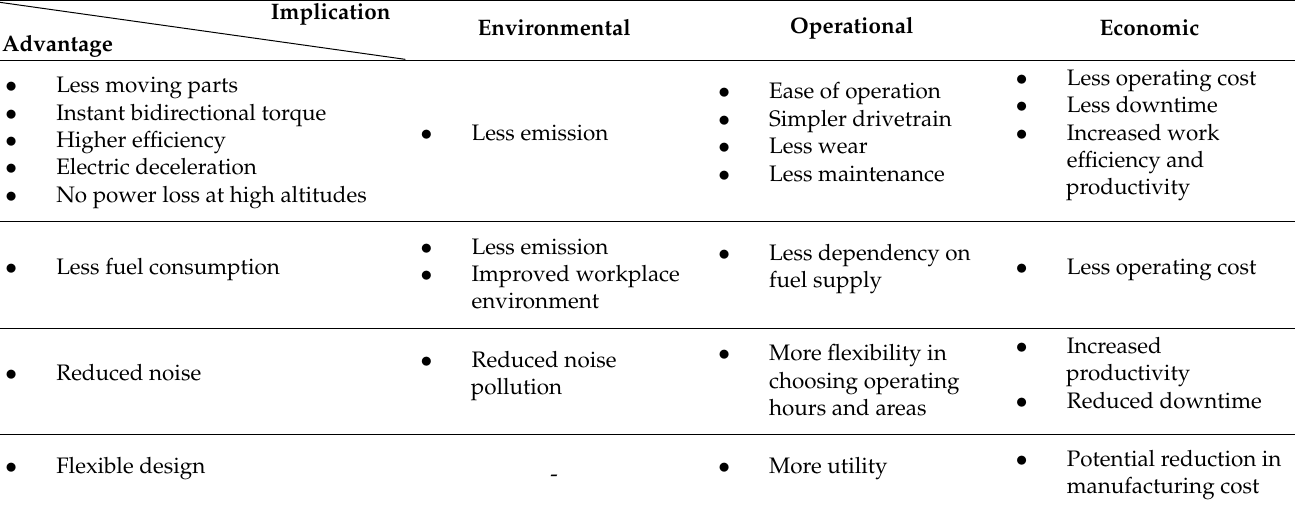
Table 8. Advantages of equipment electrification and their